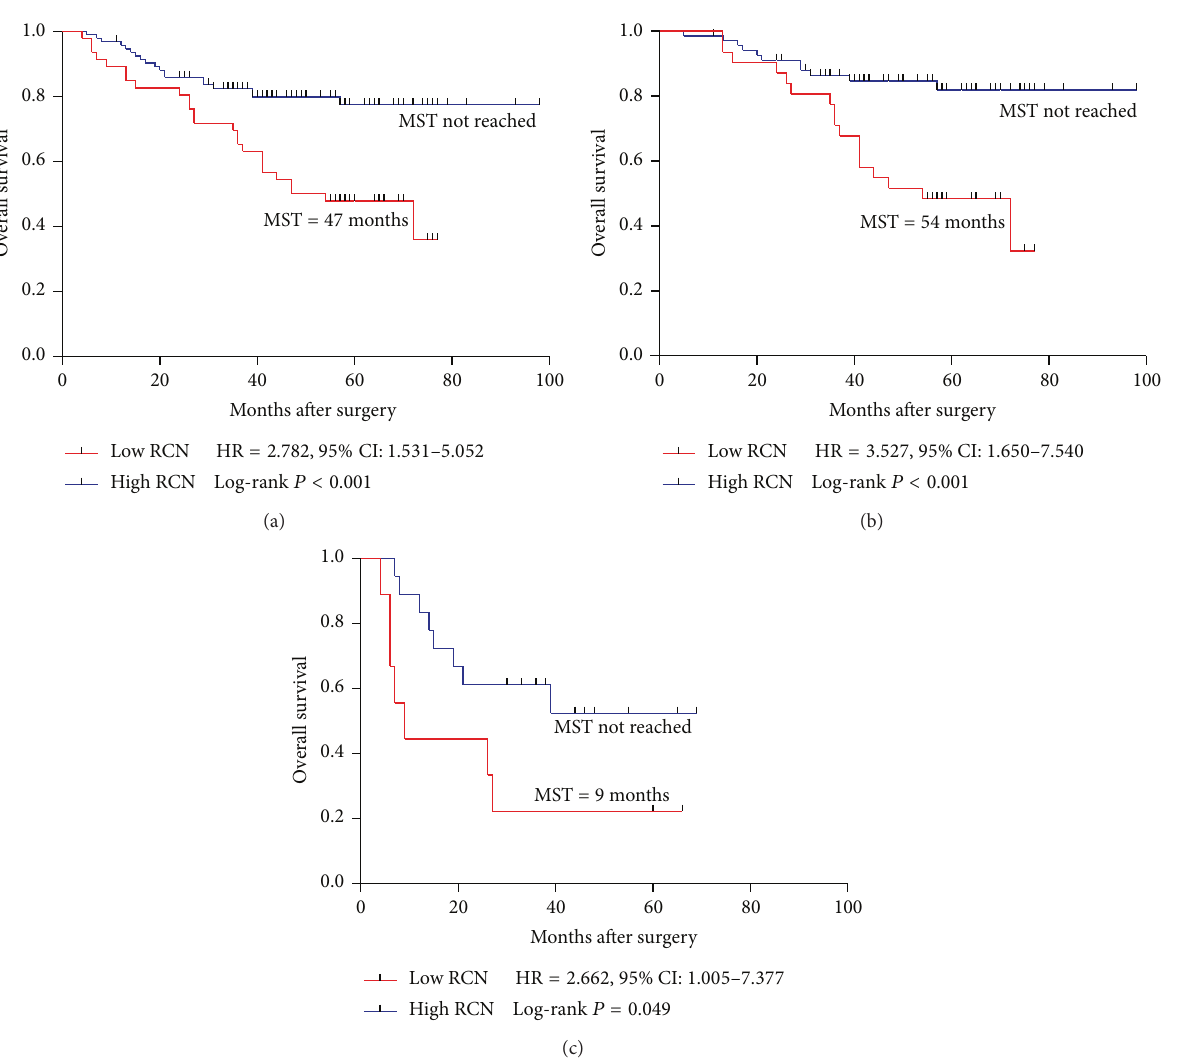
Figure 3: Kaplan-Meier survival curves of patients with stage III, IIIB, and IIIC disease receiving oxaliplatin-based chemotherapy. (a) OS in total stage III; (b) OS in stage IIIB; (c) OS in stage IIIC. MST: median survival